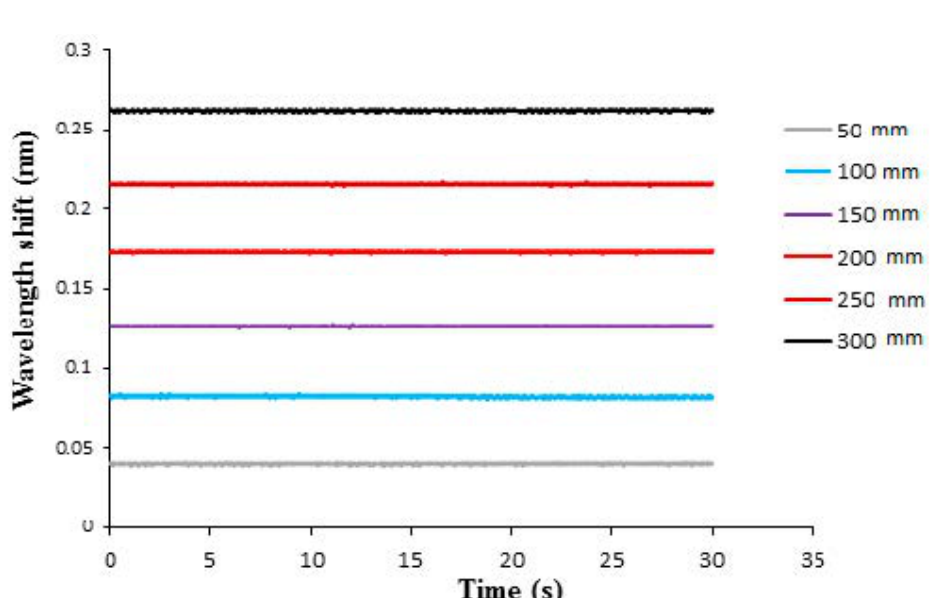
Figure 9. Bragg wavelength shift from the FBG sensor under various water levels with diaphragm thickness of 0.7 mm.